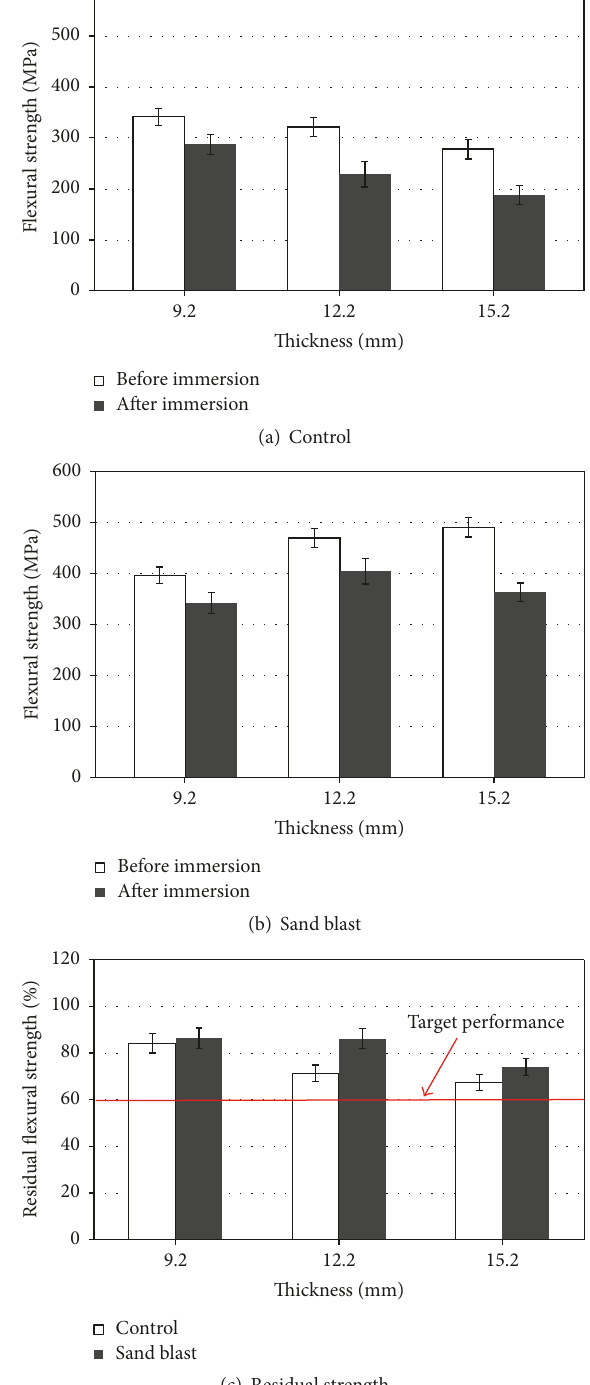
Figure 12: Flexural test results of tap water